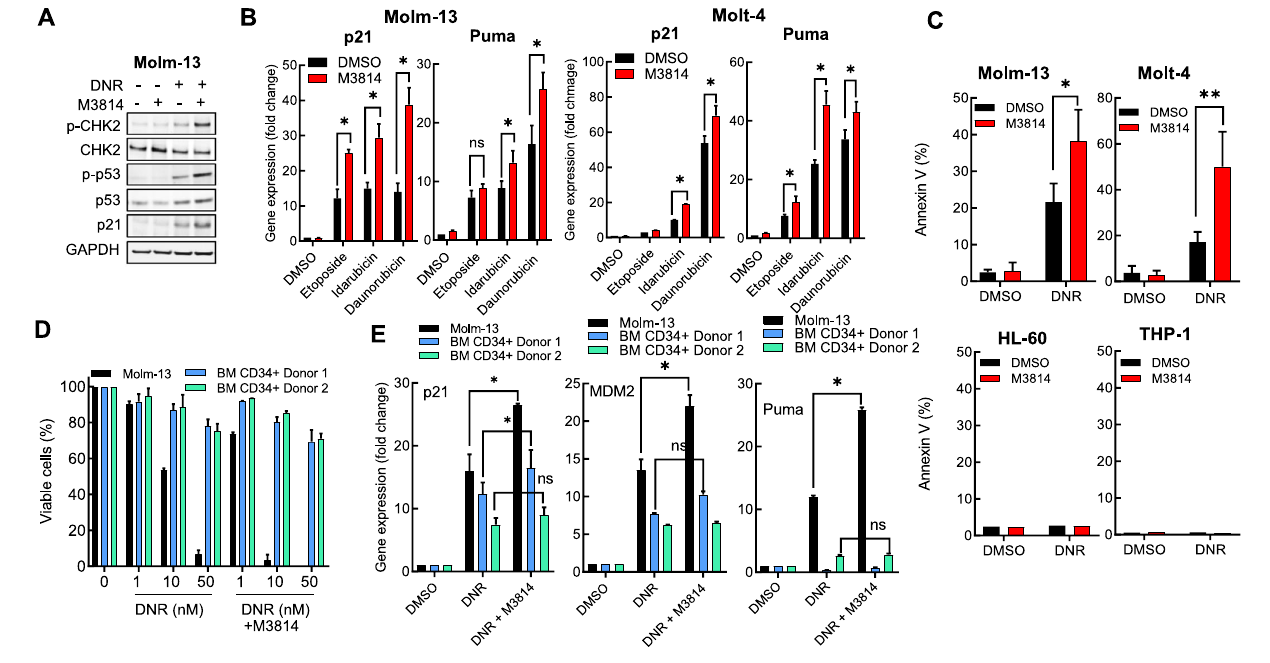
Figure 2. M3814 augments topoisomerase II inhibitor induced p53 apoptotic activity in acute leukemia cells. ( A ) Molm-13 cells were pre-treated with M3814 (300 nM) or vehicle for 45 min before addition of DNR (10 nM) and incubated for additional 24 h before preparation of protein lysates. Protein expression and phosphorylation status were assessed by Western blotting as in Fig. 1A. Panel displays cropped images from repeat blots divided and probed for different targets. Full-sized blots are shown in Supplementary Fig. 2. ( B ) Molm-13 and Molt-4 cells were pre-treated with M3814 (300 nM) or vehicle for 45 min before addition of etoposide (50 nM), idarubicin (1 nM) or daunorubicin (10 nM). RNA was isolated 4 h post-treatment and p53 target gene expression was assessed by qPCR using probes for p21 and Puma. Expression levels were normalized to GAPDH. ( C ) Molm-13, Molt-4, HL-60 and THP-1 cells were pre-treated with M3814 (300 nM) or vehicle for 45 min and exposed to DNR (1 nM). Apoptosis was assessed 24 h post-treatment by flow cytometry as in Fig. 1. D) Molm-13 cells and bone marrow CD34+ cells isolated from two healthy donors were pre-treated with M3814 (300 nM) or vehicle as above for 45 min and DNR (1, 10 or 50 nM) alone or in combination with M3814 (300 nM) was added and the cells were incubated for 4 d. Cell growth/viability was assessed by the CTG assay and expressed as percent of vehicle controls. E) Molm-13 cells and bone marrow CD34+ cells isolated from two independent healthy donors were treated as in D and p53 target gene expression was assessed by qPCR using probes for p21, Mdm2 and Puma. Expression levels were normalized to GAPDH. *p < 0.05, **p < 0.01, ***p < 0.001. NS: p >